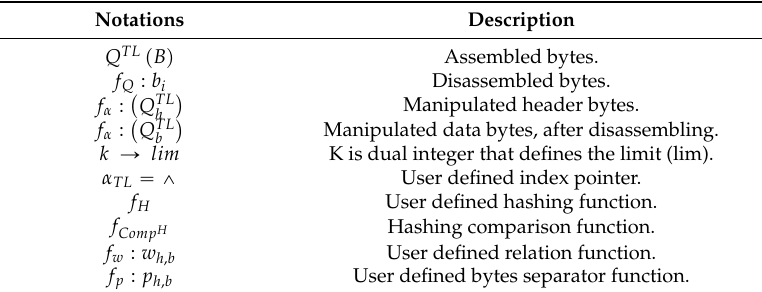
Table 3. Security notations.